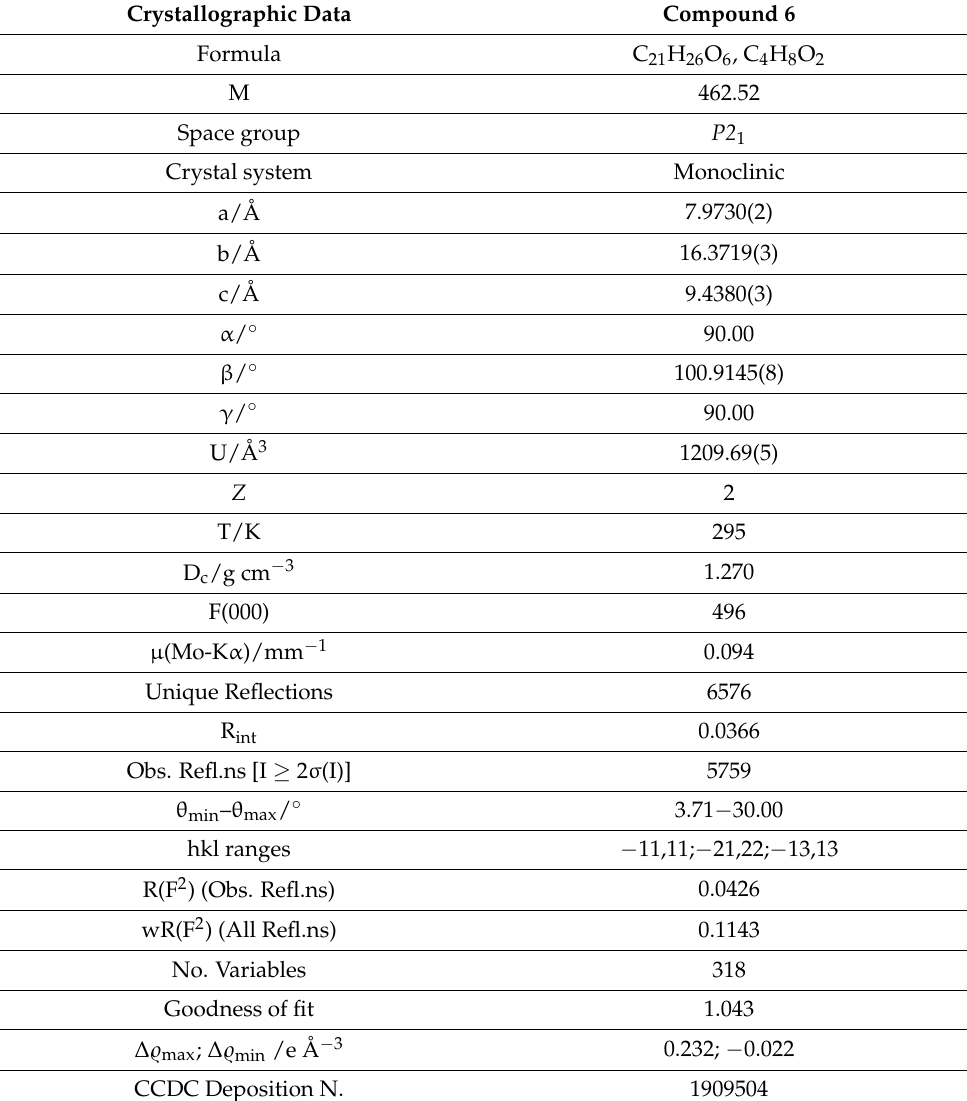
Table 1. Crystallographic